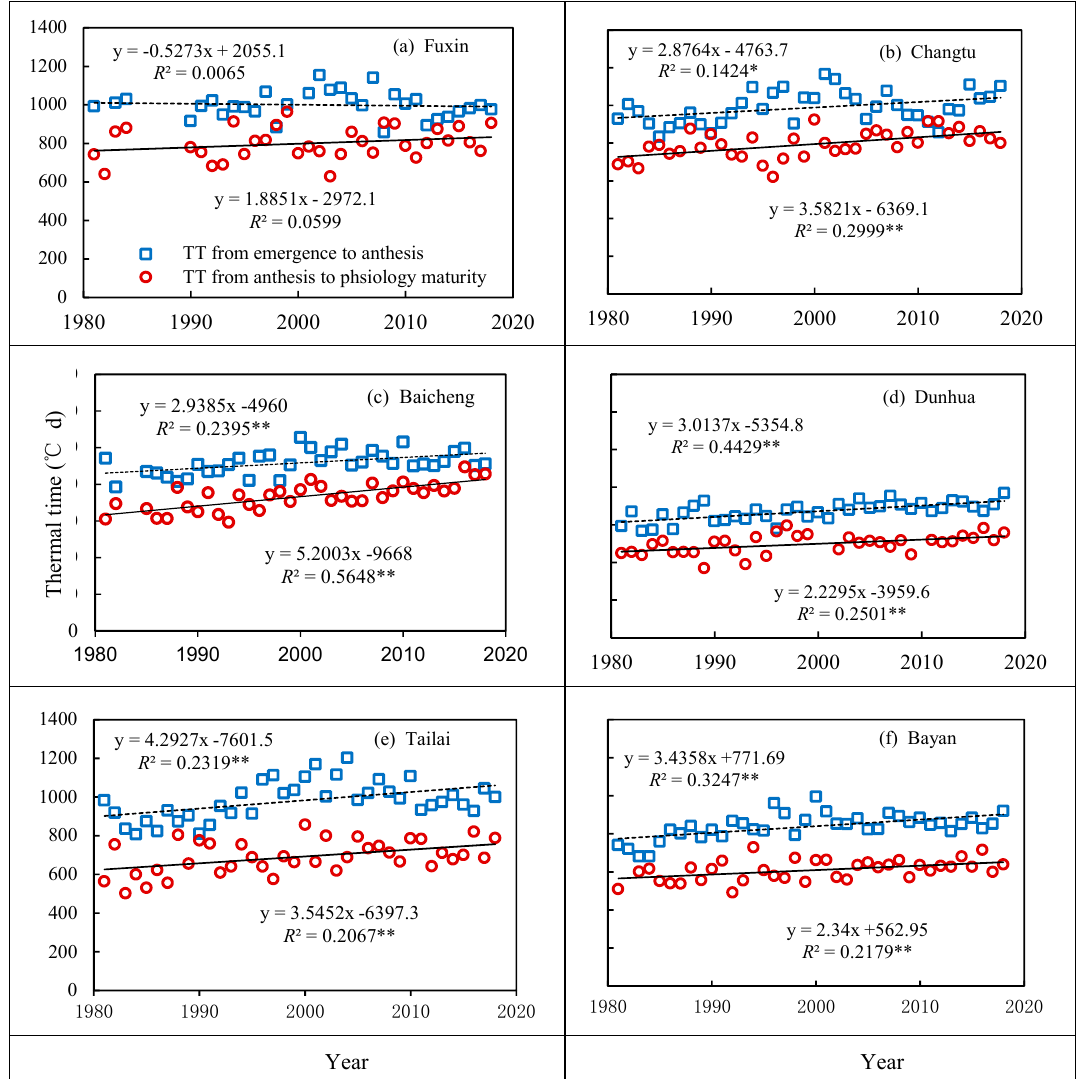
Figure 3. Time series of the thermal times during the vegetative (open boxes) and reproductive (open circles) periods of maize at Fuxin ( a ), Changtu ( b ), Baicheng ( c ), Dunhua ( d ), Tailai ( e ), and Bayan ( f ) sites in Northeast China (NEC) from 1981 to 2018. Straight lines represent the linear regression lines against years. ** p < 0.01 and * p < 0.05.